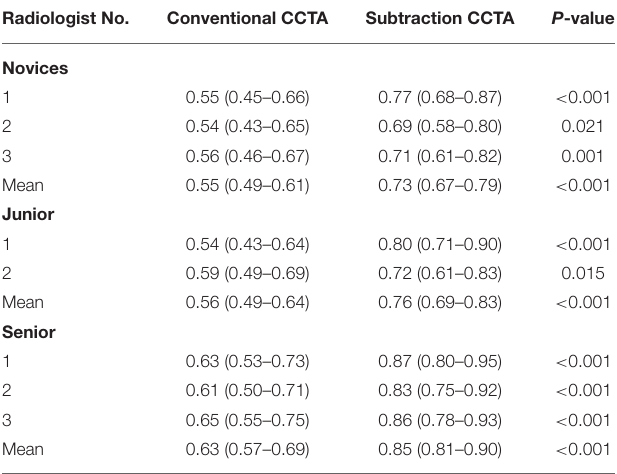
TABLE 4 | The area under the curve (AUC) for each radiologist with conventional or subtraction CCTA. Radiologist No.